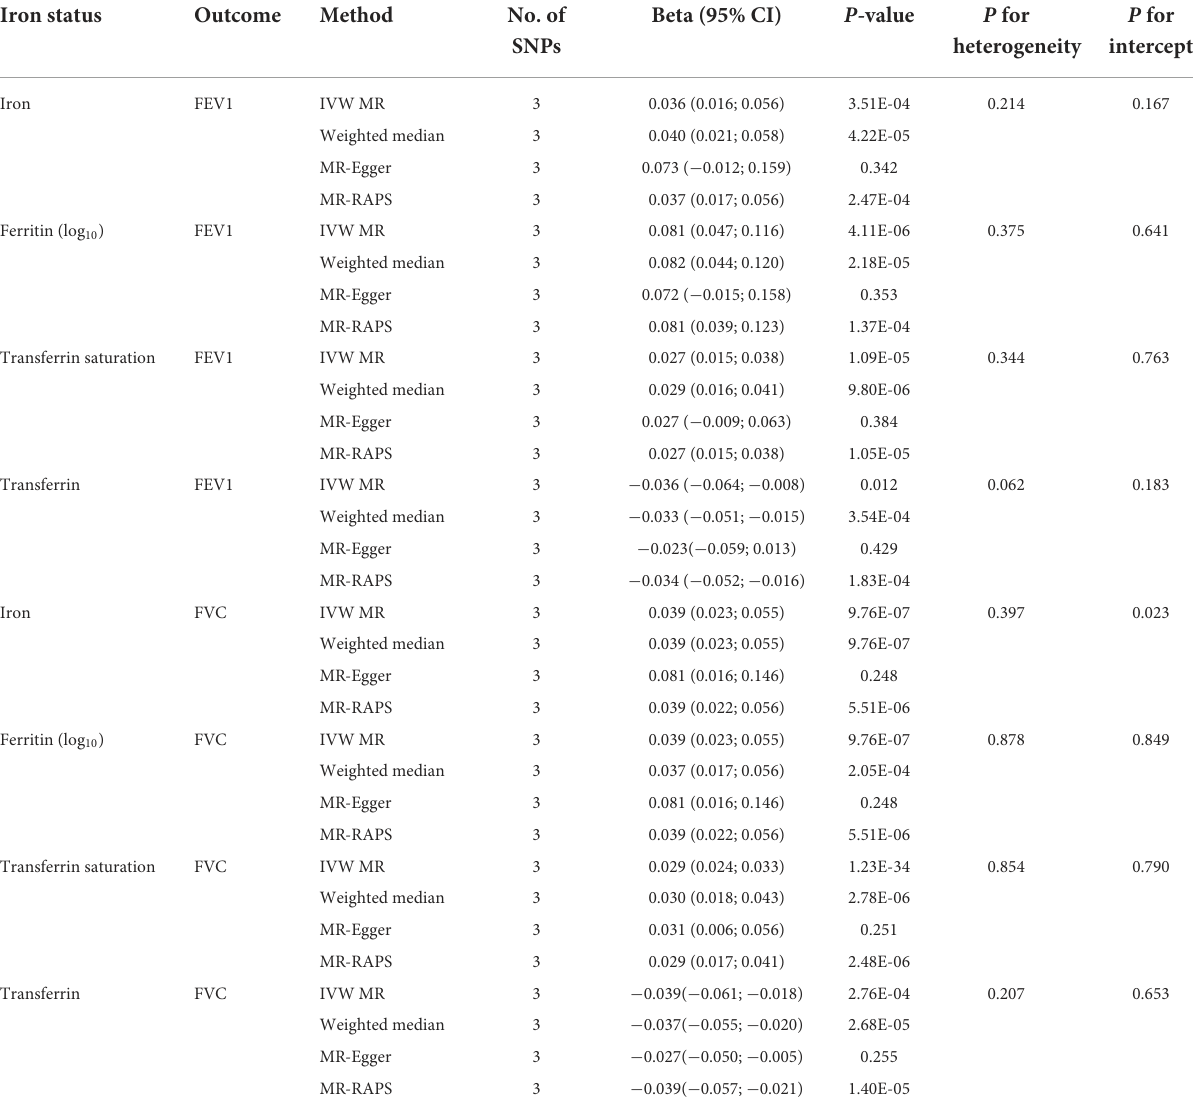
TABLE 2 Associations of genetically predicted iron status with FEV1 and FVC using the 3 SNPs associated with all 4 iron biomarkers. Iron